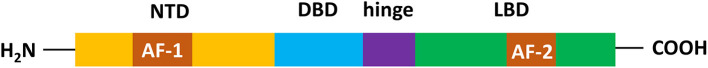
Representation of the domains structure of the nuclear receptors. LBD, Ligand binding domain; DBD, DNA binding domain; AF-1, activator function-1; AF-2, activator function-2; NTD, N-terminal domain.